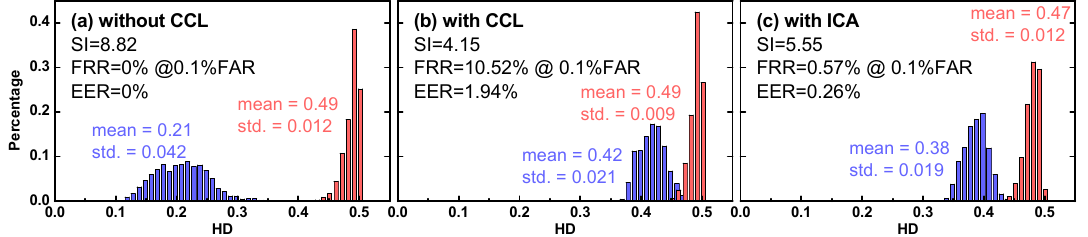
Figure 8. Experimental HD histogram for the authentic (blue) and impostor (red) distribution with 200 enrollments and 200 test images as the proof of concept, where ( a ) naked eye ( b ) CCLs and ( c ) CCLs with the ICA, respectively.